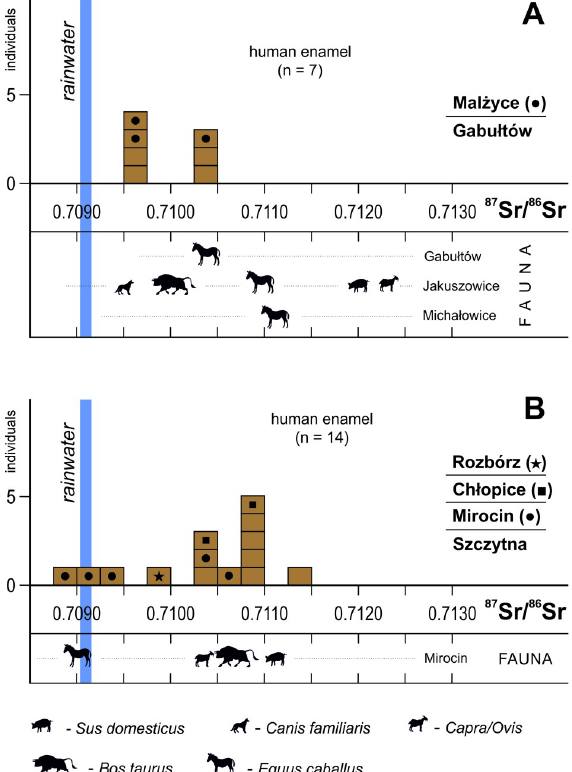
Fig 7. Strontium isotope ratios in Final Neolithic human and animal enamel in the Małopolska Upland (A) and in the Subcarpathian region (B). Each faunal silhouette indicates a single sample. The Sr isotope composition of rainwater, the most non-radiogenic element of the local environment, is